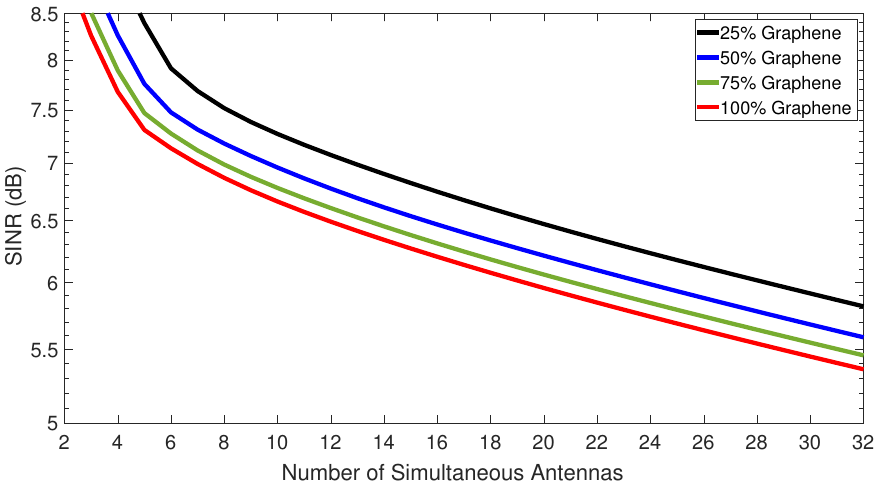
Figure 10. Signal-to-interference-plus-noise-ratio (SINR) versus the number of simultaneous antennas at the remote unit